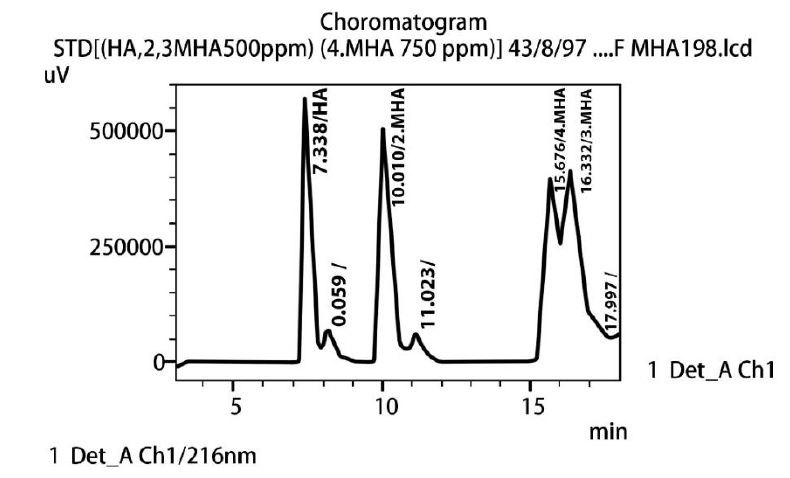
Figure 5. Chromatograms of Hippuric Acid (500 mg/L), 2-Methylhippuric Acid (500 mg/L), 3-Methylhippuric Acid (500 mg/L), and 4-Methylhippuric Acid (750 mg/L)